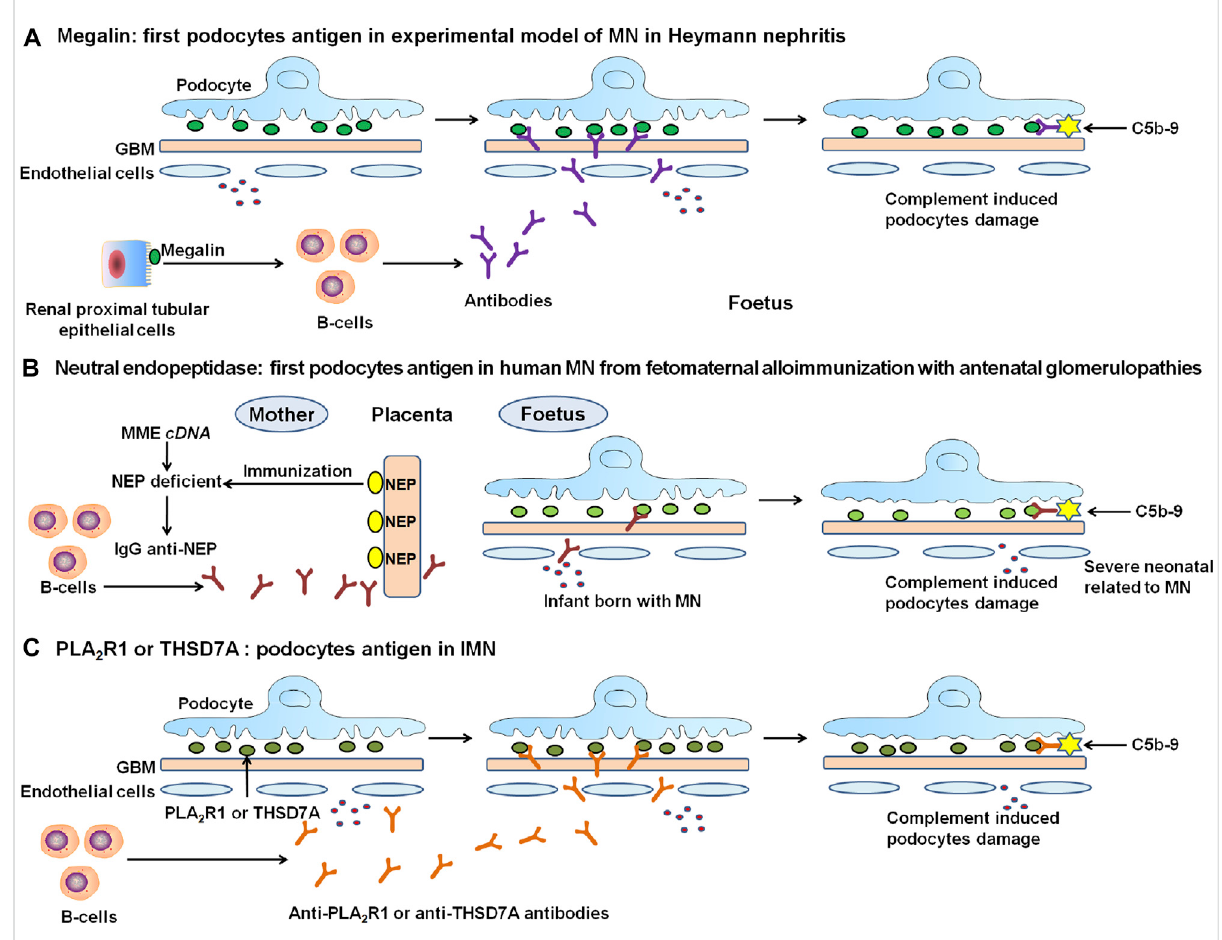
FIGURE 1 The discovery and proposed mechanisms of the representative antigens in the experimental MN and human IMN. (A) In 1982, the polyspeci fi c receptormegalinwasidenti fi edinHeymannnephritis,butnotonhumanpodocytes. (B) Inhumans,progressinMNstartedin2002withthediscovery of target antigen namely neutral endopeptidase (NEP) as a targeting antigen in alloimmune neonatal MN. (C) In 2009, Novel causal antigen PLA 2 R, which is the fi rst podocyte autoantigen identi fi ed in human IMN. Followed by PLA 2 R, in 2014, second antigen THSD7A was identi fi ed in human IMN. PLA 2 R-related and THSD7A-related MN accounted for about 70% and 1% – 5% of IMN patients, respectively. The formation of immune complexes is the circulation of antibodies binding to endogenous antigens in podocytes. Once formed, these complexes are capped then released into the subepithelial region. They attach to GBM, resist degradation, and persist as immune deposits. Immune deposits form by repeated cycles, whichcouldactivatecomplementpathway.Thedepositsofsubepithelialimmunecomplexesandcomplementactivationdamagethepodocyteand lead to severe